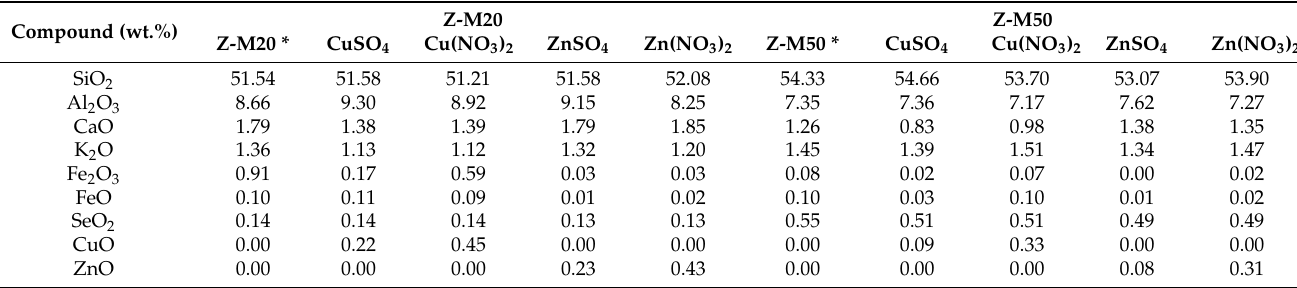
Table 2. The basic chemical composition of zeolites.